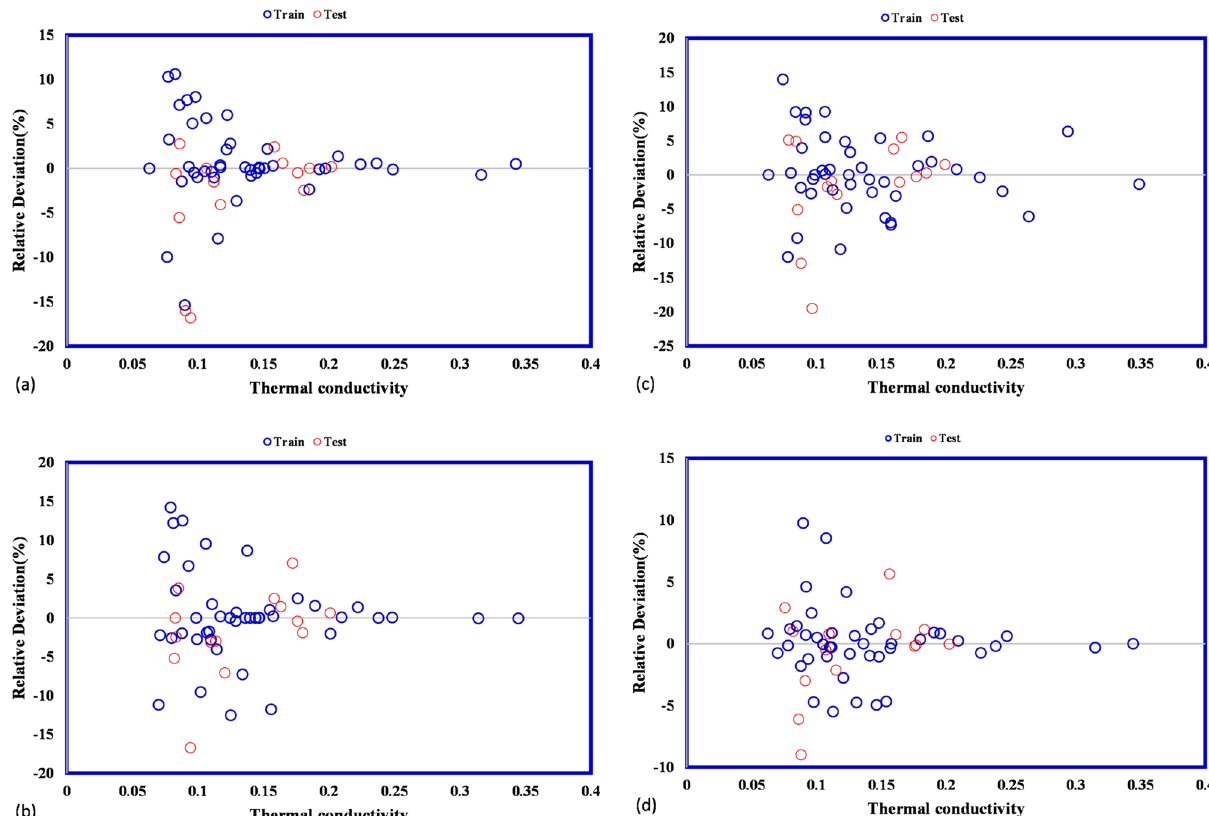
Figure 7. Comparison of model outputs and experimental values for ( a ) exponential, ( b ) squared exponential, ( c ) rational quadratic, ( d ) matern.